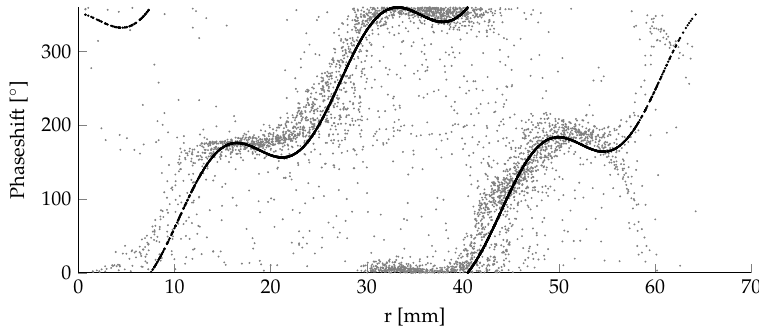
Figure 11. Phase approximation of the equation to measured values. Table 3. Fit results phase